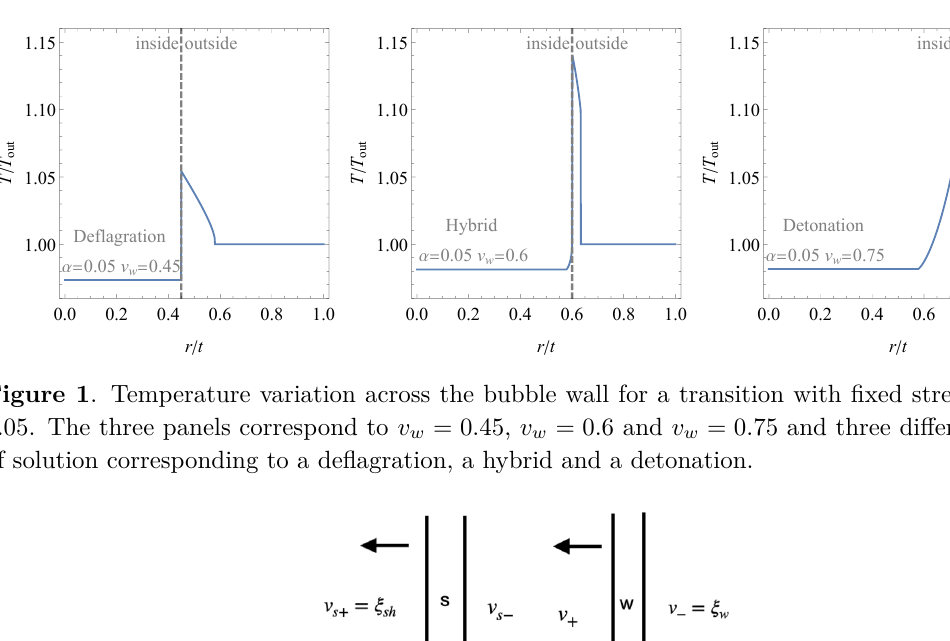
Figure 2 . Diagrammatic picture for a deflagration bubble (w) propagating to the left as indicated by the arrows as well as the shock front (s) propagating in front of it. The fluid velocities and temperatures measured with respect to each wall interface are also